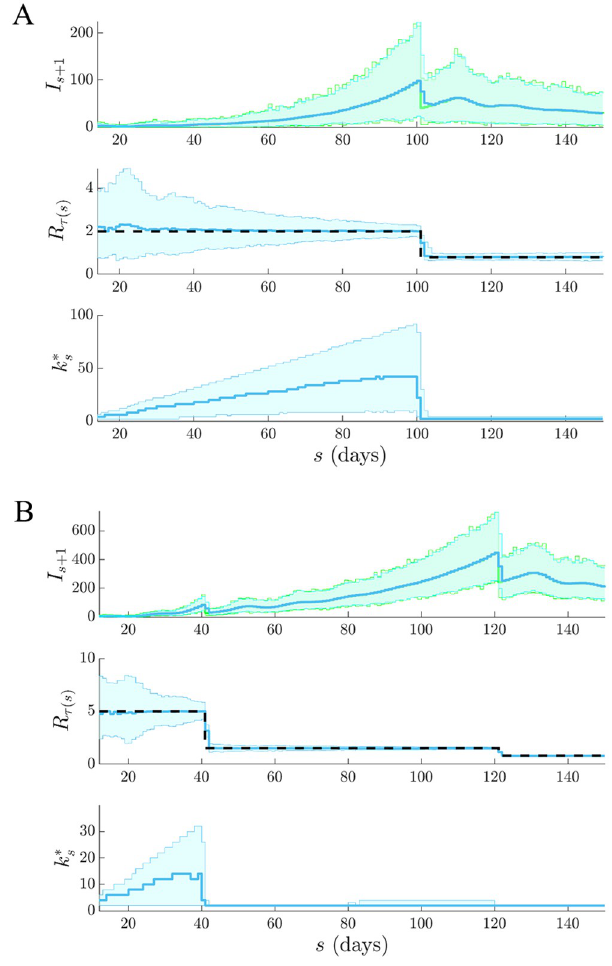
Fig 6. Real-time APE sensitivity to rapid epidemic control. We simulate 10 3 independent epi-curves under renewal models with (A) one effective and (B) two partially effective interventions. Top graphs give the true (green) and predicted (blue) incidence ranges, the middle ones provide estimates of R under the final k � and the bottom graphs s t illustrate how successive k � choices from APE can reliably and rapidly detect the impact of real-time control s